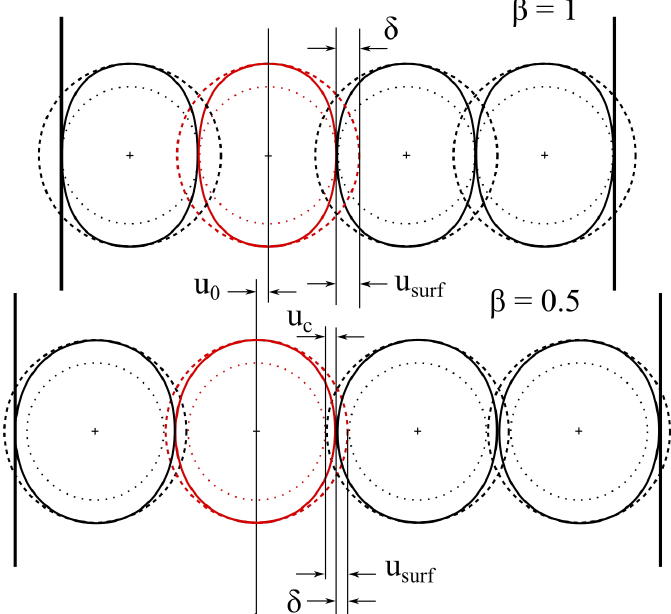
Figure 2. Sketch of an ideal section of active material. Dotted lines refers to rest condition (no lithium inserted in particle), dashed line refers to the free expansion of the particle as a result of lithiation and solid line refers to particle surface considering both expansion due to lithiation and contact. The upper figure refers to extremely rigid boundary ( β = 1) and the lower figure refers to the case β = 0.5 ( δ = u 0